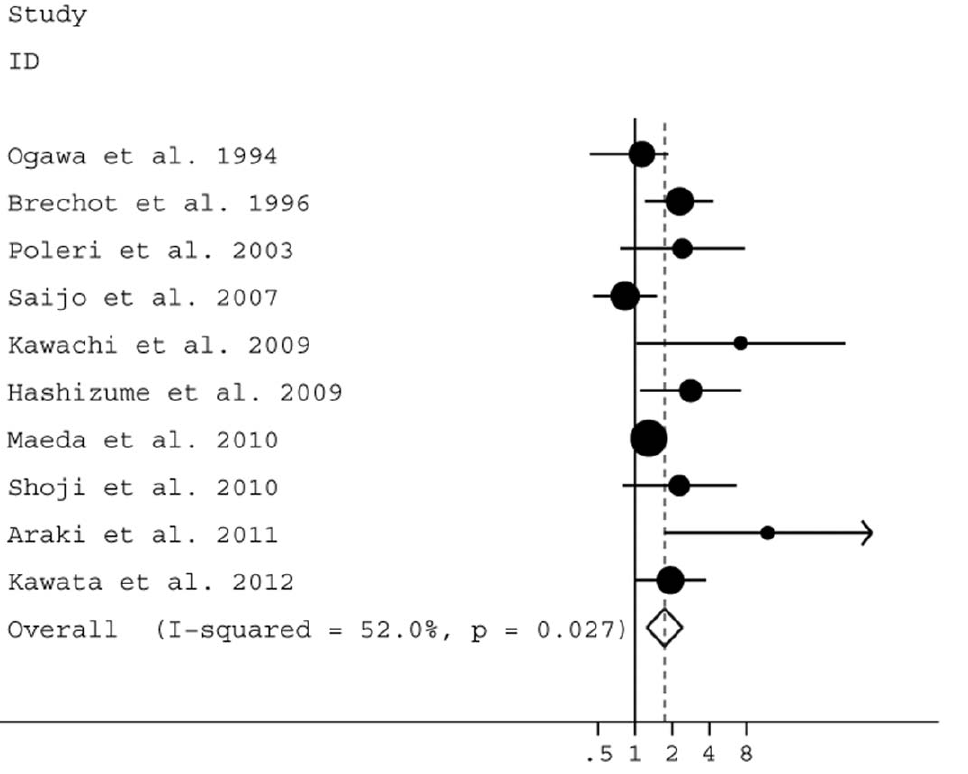
Figure 1. Forest plot showing the combined relative hazard ratio for relapse-free survival in all patient populations by multivariate analysis.